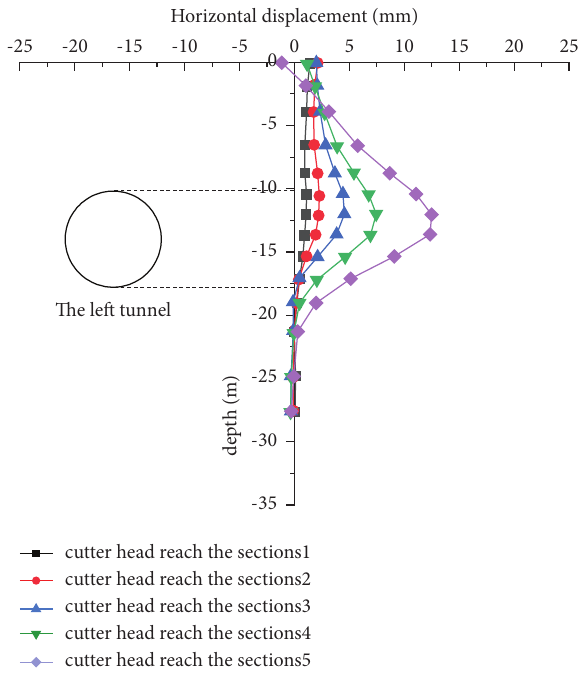
Figure 19: The left tunnel excavation gap filling.